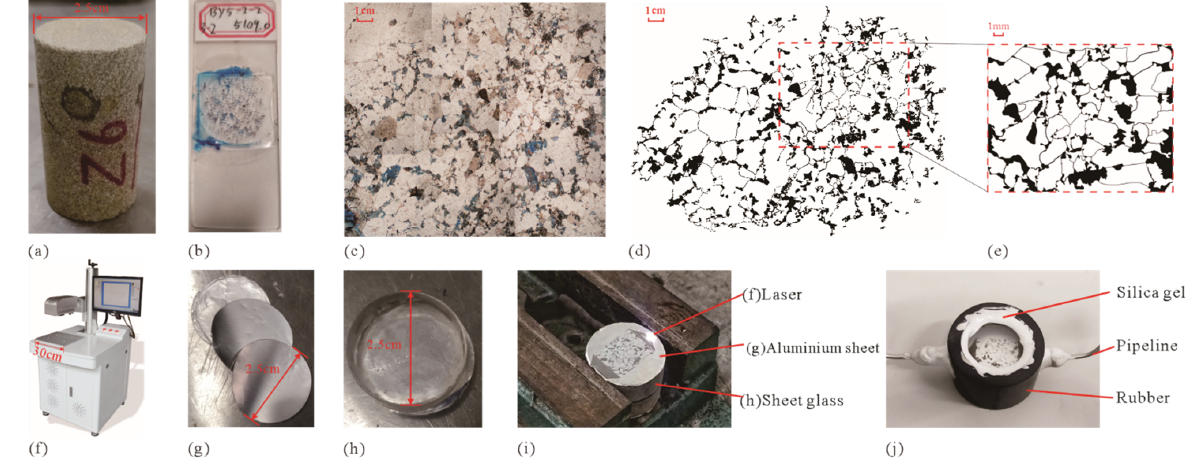
Figure 2. Microetching modeling fabrication process: ( a ) core plug; ( b ) casting thin section; ( c ) microscopic image of the casting thin section; ( d ) rock core throat structure extraction; ( e ) microscopic model core throat structure; ( f ) industrial laser marking machine; ( g ) thin aluminum sheet; ( h ) transparent thick glass sheet; ( i ) laser engraving; ( j ) MEM after encapsulation.